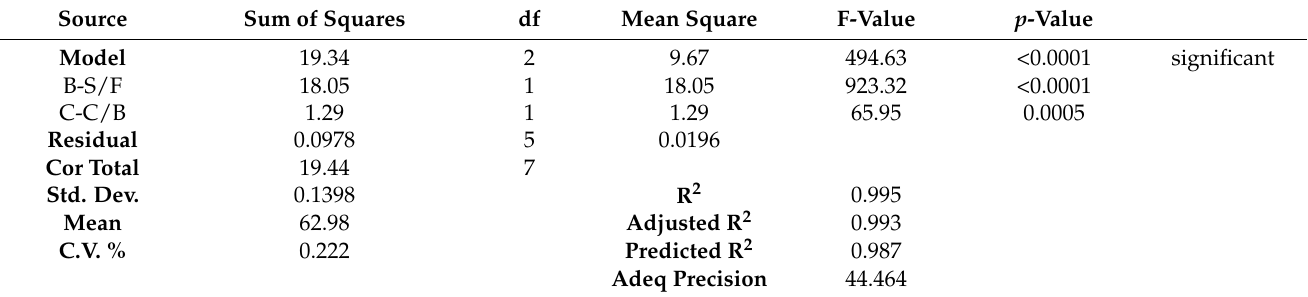
Table 5. Analysis of variance (ANOVA) for the regression model of H 2 content (%vol., dry basis).